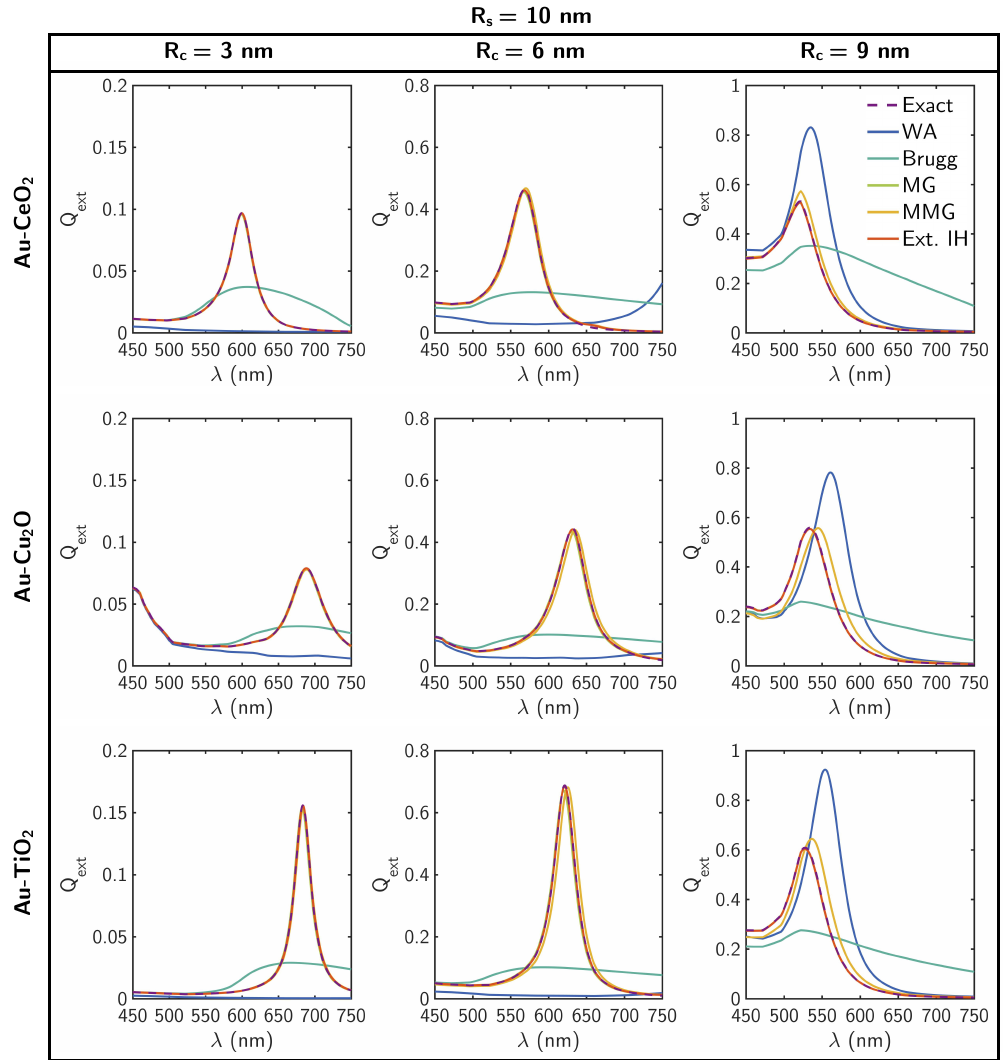
Figure 4. Extinction efficiency ( Q ext ) of Au-CeO 2 (top row), Au-Cu 2 O (middle row) and Au-TiO 2 (bottom row) core-shells of total radius R s = 10 nm and different core sizes: R c = 3 nm (first column), R c = 6 nm (middle column) and R c = 9 nm (right column). The exact solution is compared with different effective medium theories: weighted average (WA), Bruggeman (Brugg), Maxwell Garnett (MG), Mie theory based Maxwell Garnett (MMG) and the proposed approach (Ext.